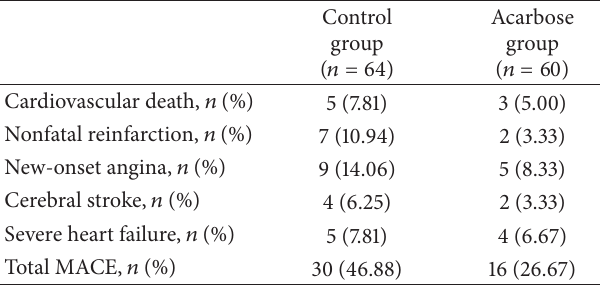
Table 2: MACE among the study patients in the mean 2.3-year follow-up ( 𝑛 ,